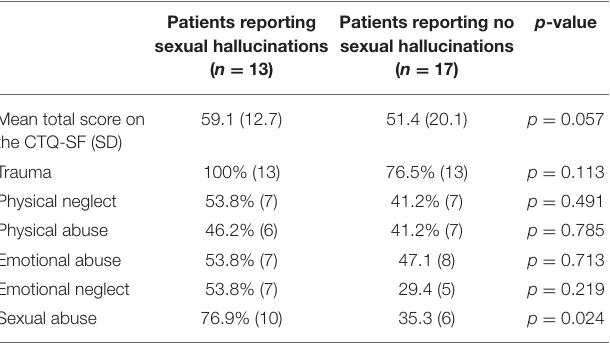
TABLE 2 | Rates for various types of childhood trauma as reported by patients experiencing sexual hallucinations, vs. those experiencing no sexual hallucinations. Patients reporting sexual